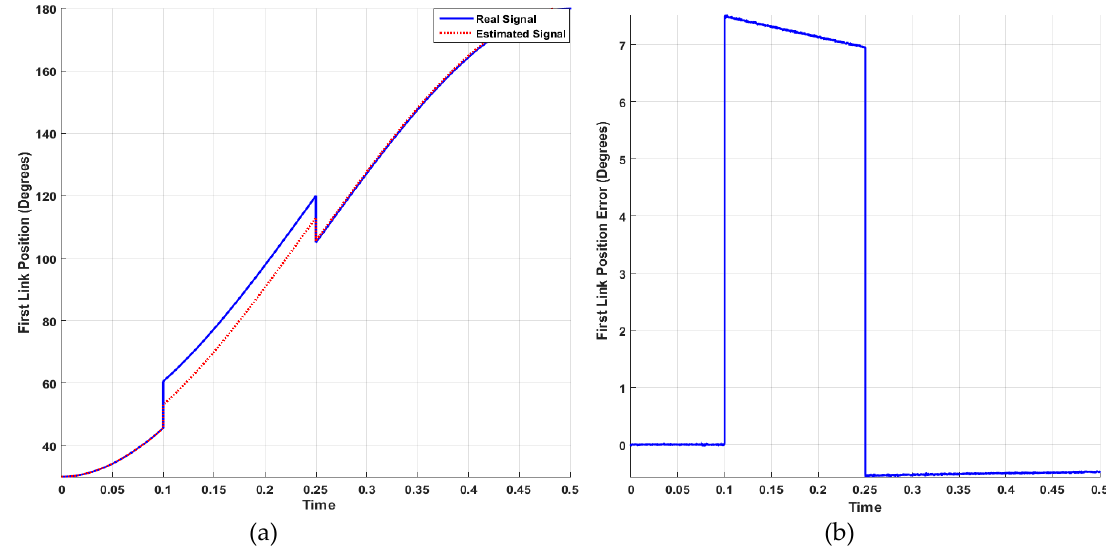
Figure 3. ARX–Laguerre proportional integral (PI) observer method for first-link fault estimation in the faulty condition: ( a ) Real and estimated output position and ( b ) estimation error signal.